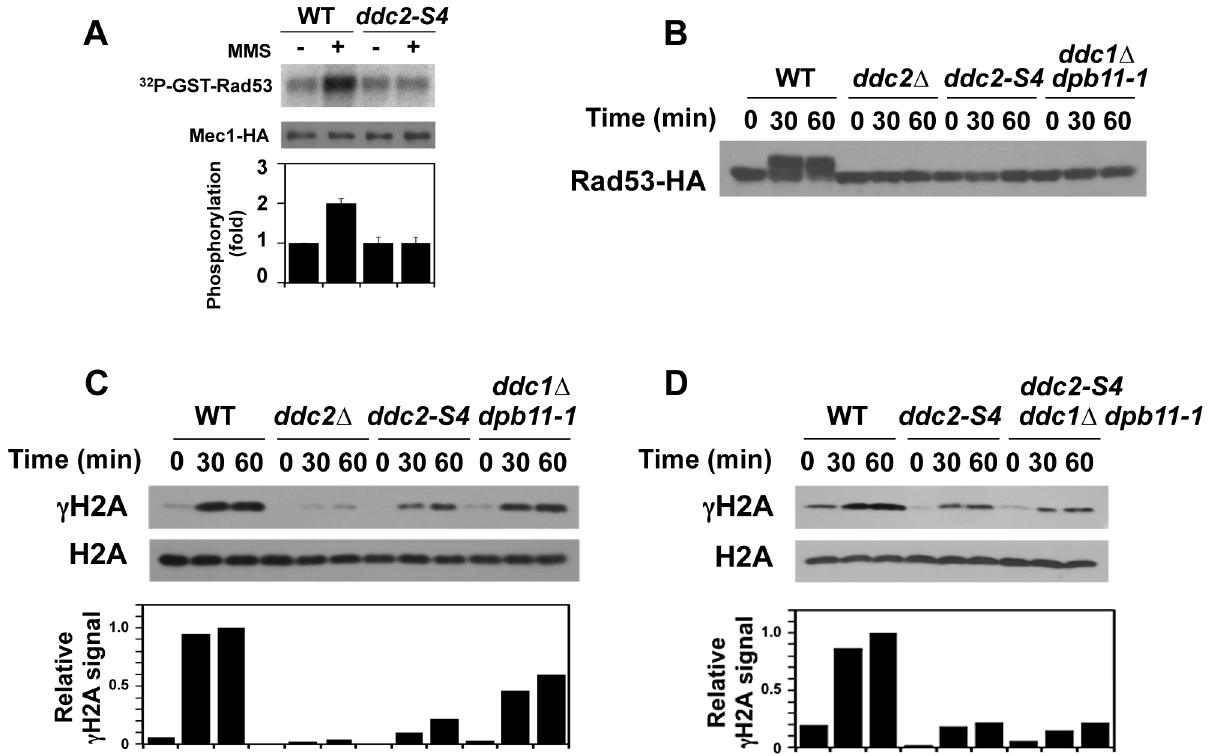
Figure 5. Effect of ddc2-S4 on Mec1 activation after DNA damage. (A) Effect of ddc2-S4 mutation on Mec1 activation. Wild-type (KSC1635) and ddc2-S4 (KSC2158) cells expressing Mec1-HA protein were subjected to the in vitro kinase assay as in Fig. 1. (B) Effect of ddc2-S4 or ddc1 D dpb11-1 mutation on Rad53 phosphorylation at G2/M. Wild-type (KSC1178), ddc2 D (KSC1234), ddc2-S4 (KSC3153) or ddc1 D dpb11-1 (KSC3190) cells expressing Rad53-HA were grown at 25 u C and arrested with nocodazole at G2/M. Cells were then exposed to 0.05% MMS. Cells were collected at the indicated time point, and extracts were subjected to immunoblotting analysis with anti-HA antibodies. (C) Effect of ddc2-S4 or ddc1 D dpb11-1 mutation on histone H2A phosphorylation at G2/M. The same extracts used in B were analyzed by immunoblotting with anti-phospho S129 ( c H2A) or anti-H2A antibodies. (D) Histone H2A phosphorylation in ddc2-S4 single and ddc2-S4 ddc1 D dpb11-1 triple mutants at G2/M. Wild-type (KSC1178), ddc2-S4 (KSC3153) or ddc2-S4 ddc1 D dpb11-1 (KSC3244) cells were grown at 25 u C and arrested with nocodazole at G2/M. Cells were then exposed to 0.05% MMS. Cells were collected at the indicated time point, and extracts were analyzed as in C.